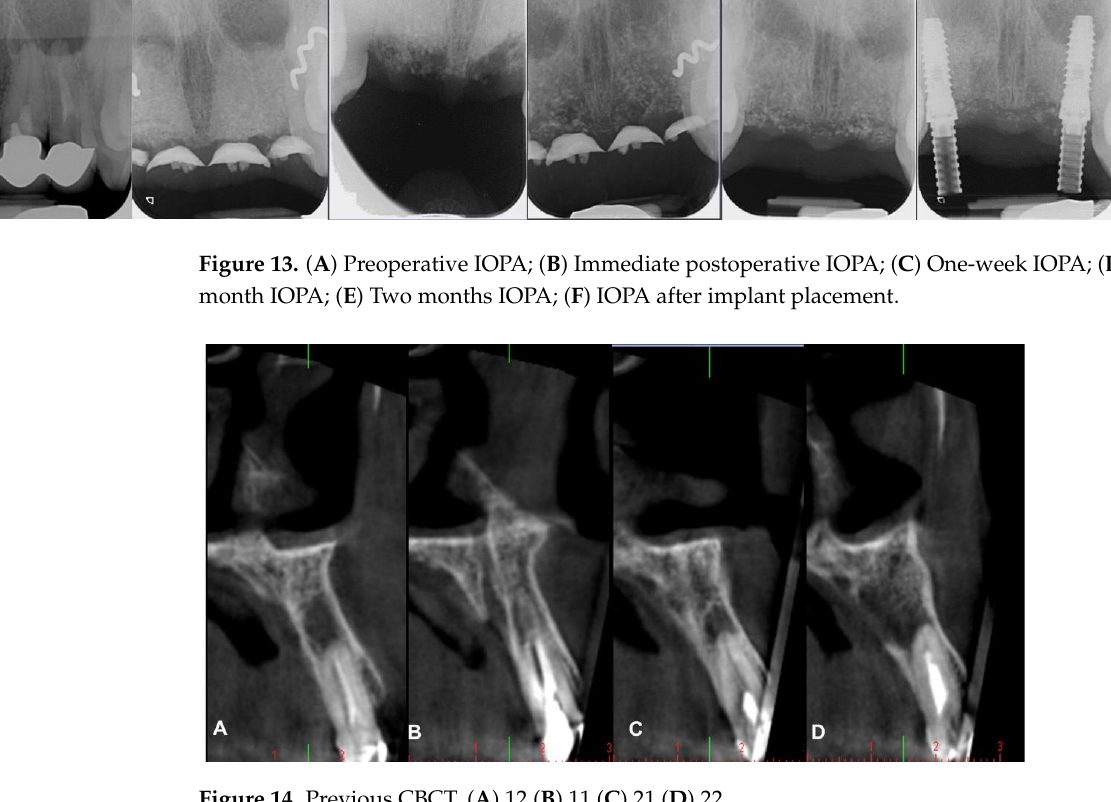
Figure 15. ( A ) Preoperative occlusal view; ( B ) Dental extractions; ( C ) Placement of Bond Apatite ® ; ( D ) Suture; ( E ) 7 days’ follow -up; ( F ) 15 days’ follow -up.